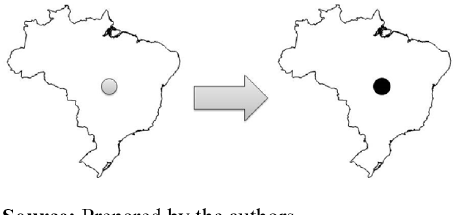
Figure 3. Representation of scaling